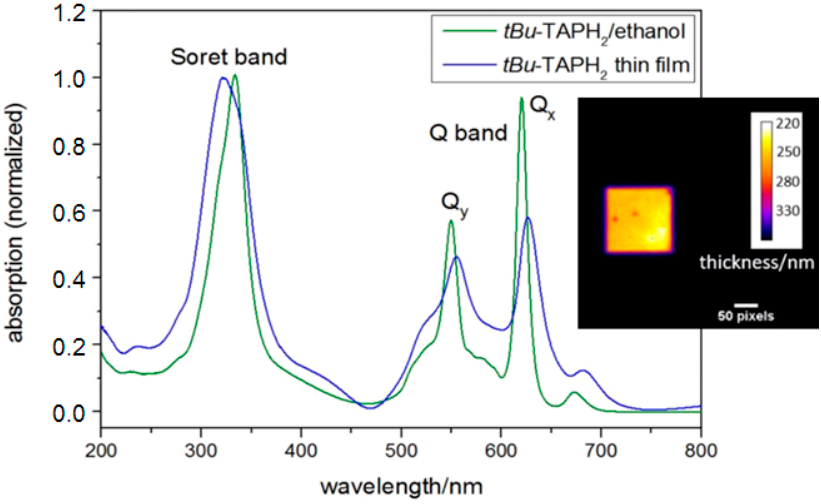
Figure 10. UV/Vis spectrum of TAP in solution and prepared as a thin film (thickness of 120 nm). Inset: EUV transmission image of a thin film TAP sample (thickness about 250